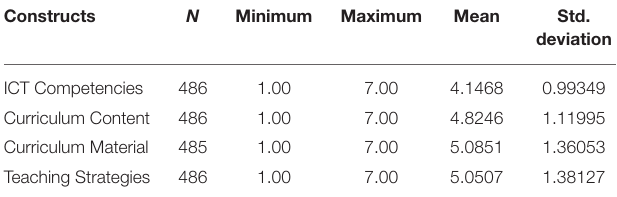
TABLE 6 | Descriptive